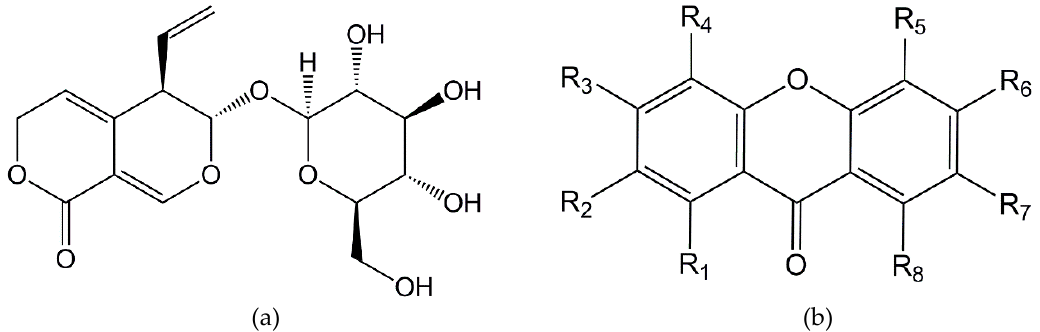
Figure 3. Schematic structures: ( a ) gentiopicroside; ( b ) xanthone (template). The different substitutions in the R1–R8 positions, leading to the xanthone molecules used in the docking protocol, are described in Table 3.